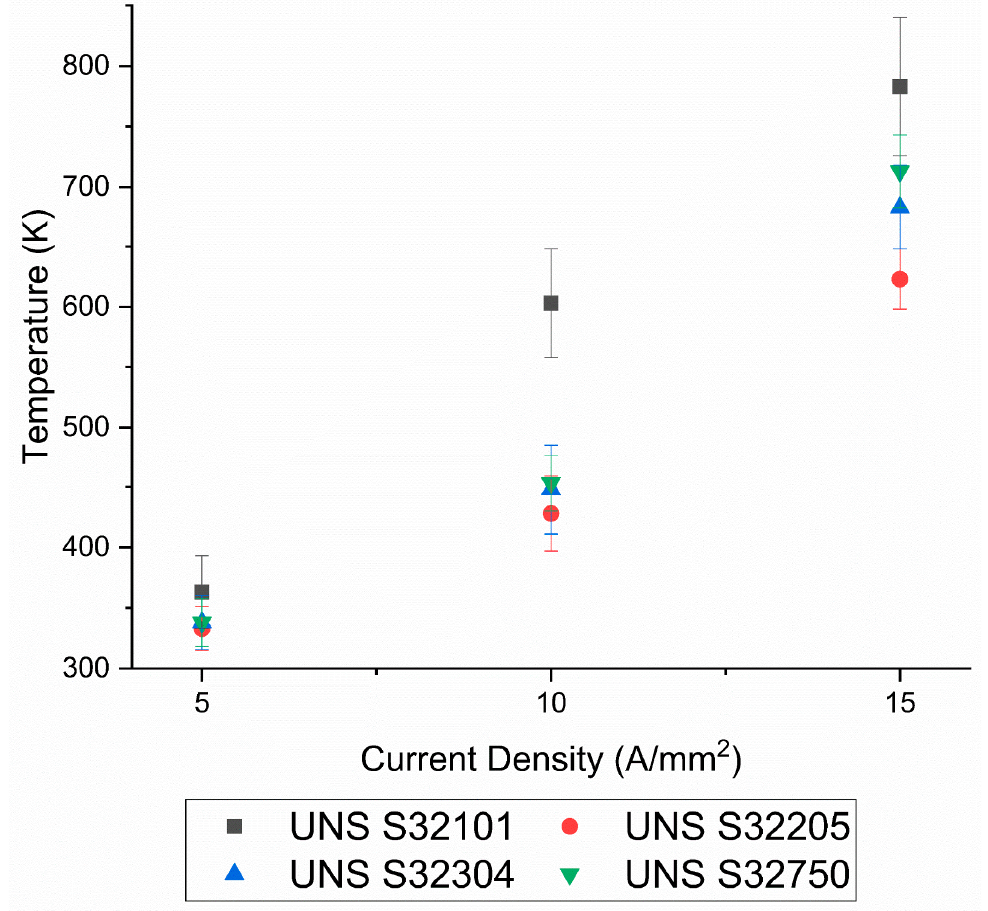
Figure 7. Mean temperatures reached by DSS grades due to the applied current densities.